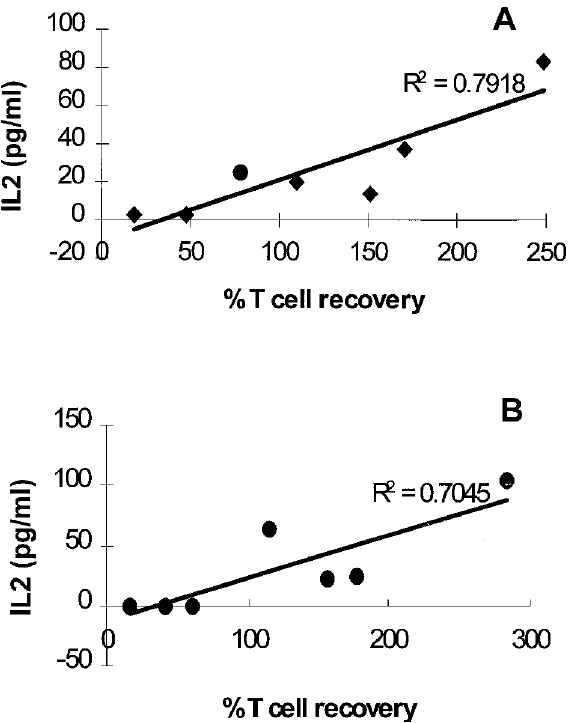
FIG. 1. Correlation between IL2 levels on POD5 (A) and POD7 (B) and T-cell recovery on POD10 in rejecting patients.